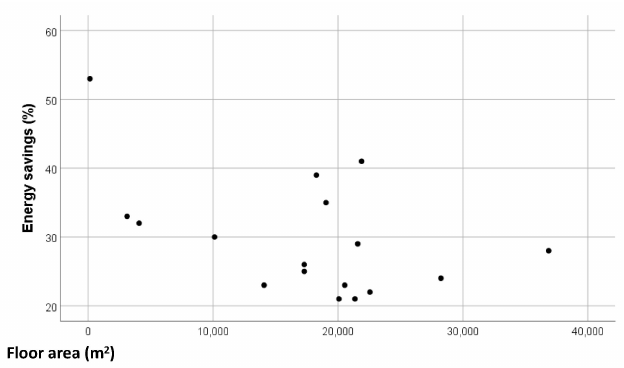
Figure 5. Energy savings per floor